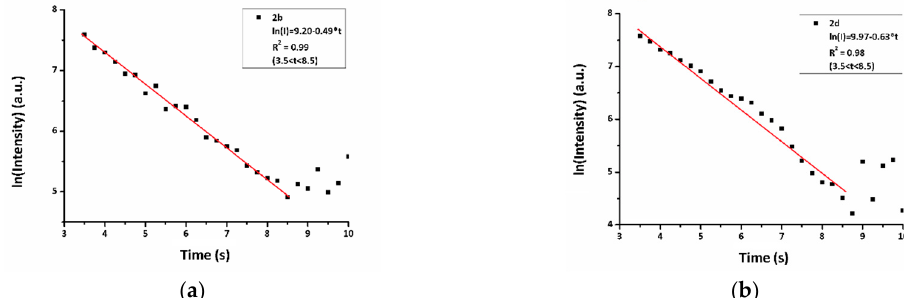
Figure 4. First-order plots for the coordination of Cu 2 + with ( a ) 2b and ( b )